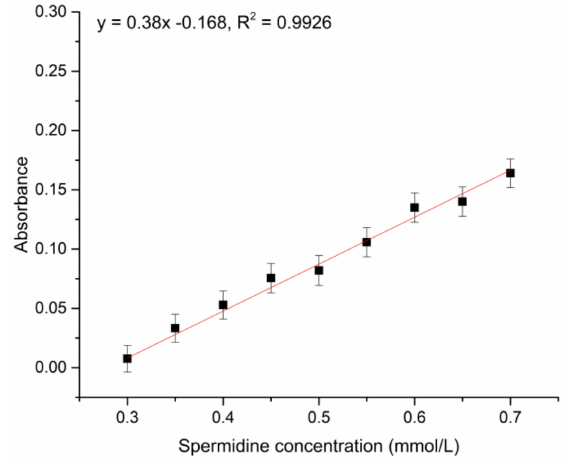
Figure 1. Standard spermidine